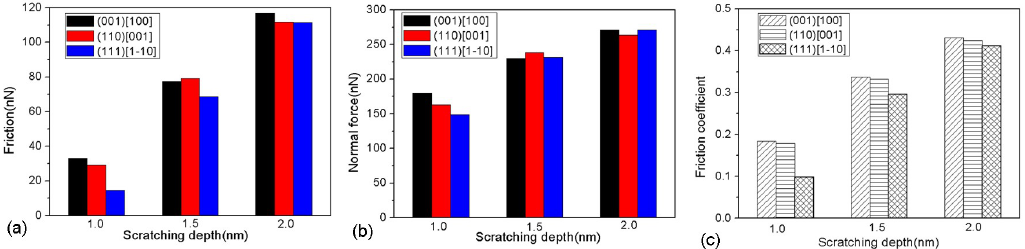
Figure 11. ( a ) The average friction force, ( b ) normal force, and ( c ) friction coefficient in scratching process for different crystallographic orientations.